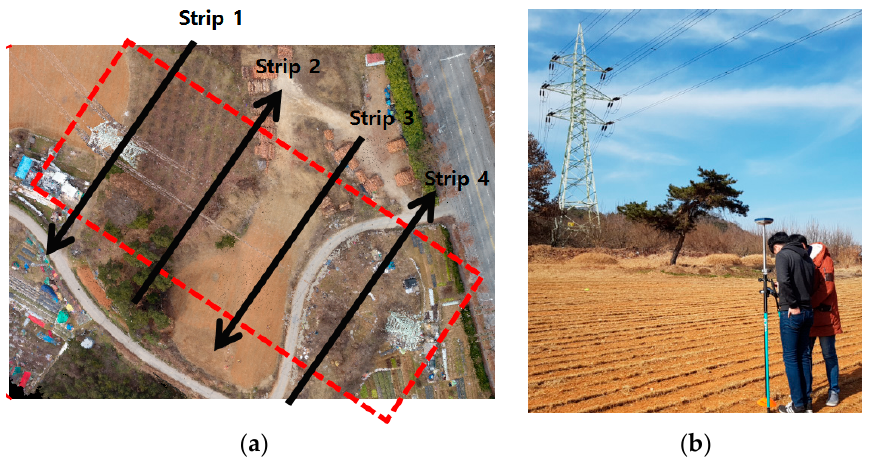
Figure 6. Test site ( a ) and GNSS surveying ( b ).